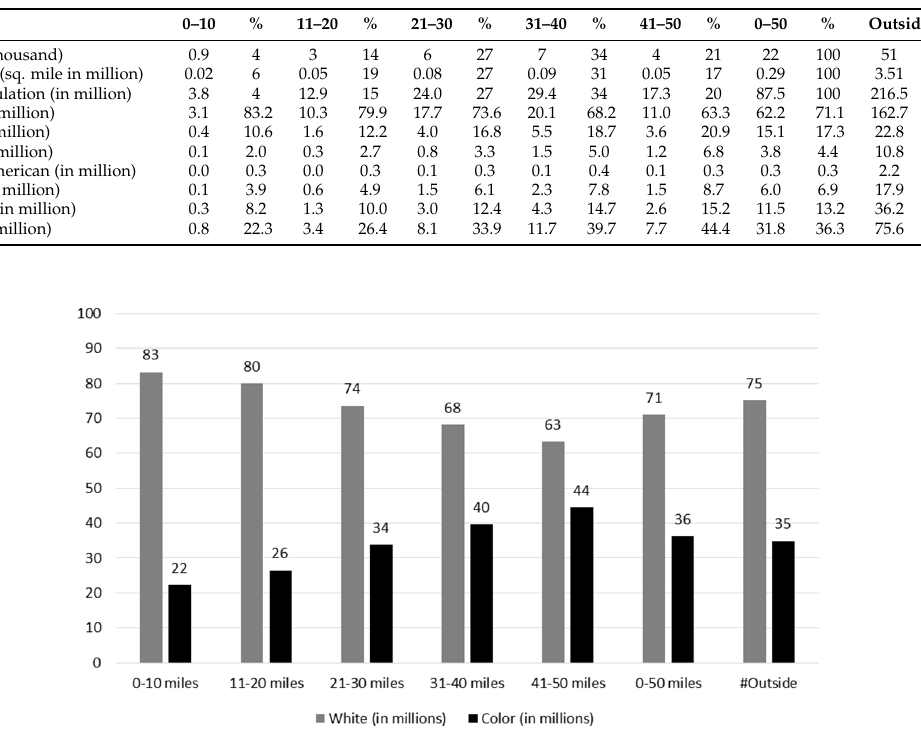
Figure 1. Demographic Composition of Percent white and color according to area, sorted by distance from any one of the 61 commercial NPPs, based on 2010 American Community Survey data.